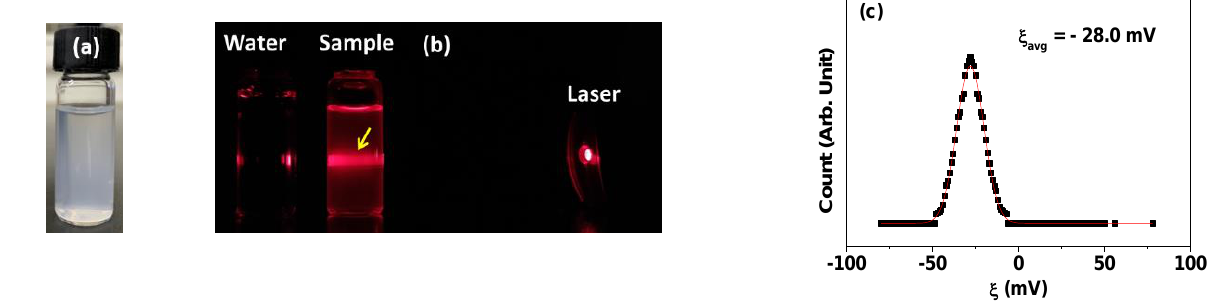
Figure 3. ( a ) Photograph of an aqueous solution of PASA-coated Gd 2 O 3 nanoparticles. ( b ) Laser scattering (or Tyndall effect) (indicated using an arrow) due to collisions between laser light and nanoparticle colloids in solution whereas no such laser scattering was observed in triple-distilled water. ( c ) Zeta potential curve.